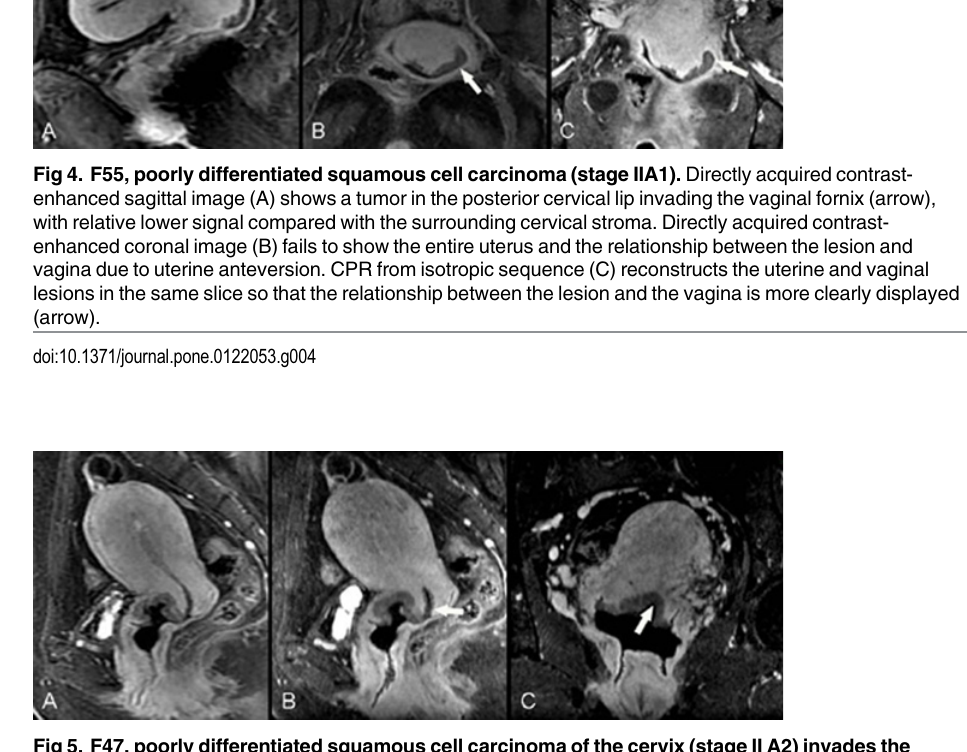
Fig 5. F47, poorly differentiated squamous cell carcinoma of the cervix (stage II A2) invades the vaginal fornix and cervical canal mucosa. Directly acquired contrast-enhanced sagittal image (A) shows a tumor in the anterior cervical lip with relative lower signal compared with the surrounding cervical stroma. Oblique sagittal image (B) and coronal CPR image (C), which were both reconstructed by the Isotropy, show more clearly that the lesion has spread to the cervical canal and vaginal fornix (arrow).